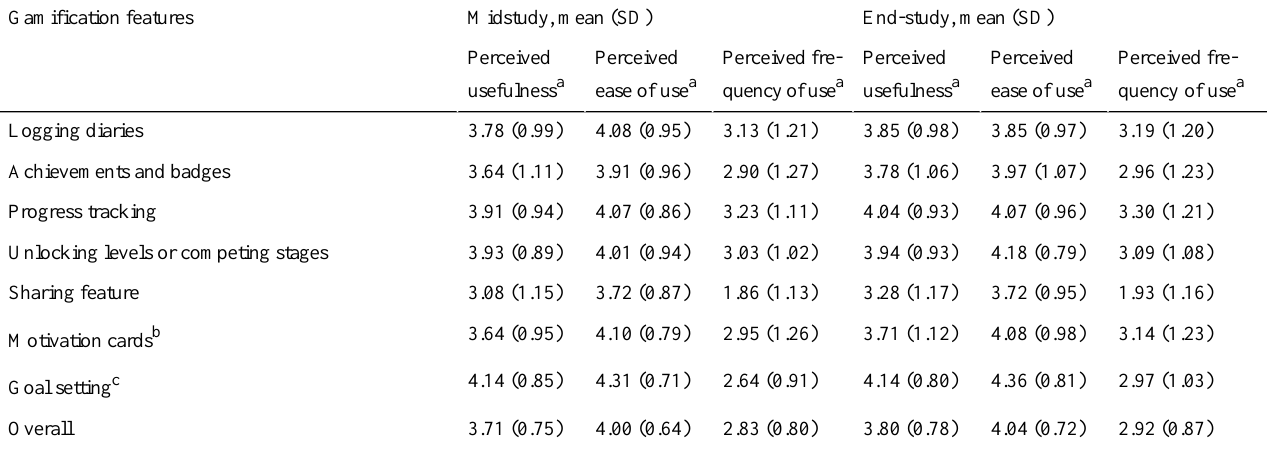
Table 2. Overview of perceived frequency of use, ease of use, and usefulness of gamification features embedded in the Kwit and Quit Genius apps (n=116).